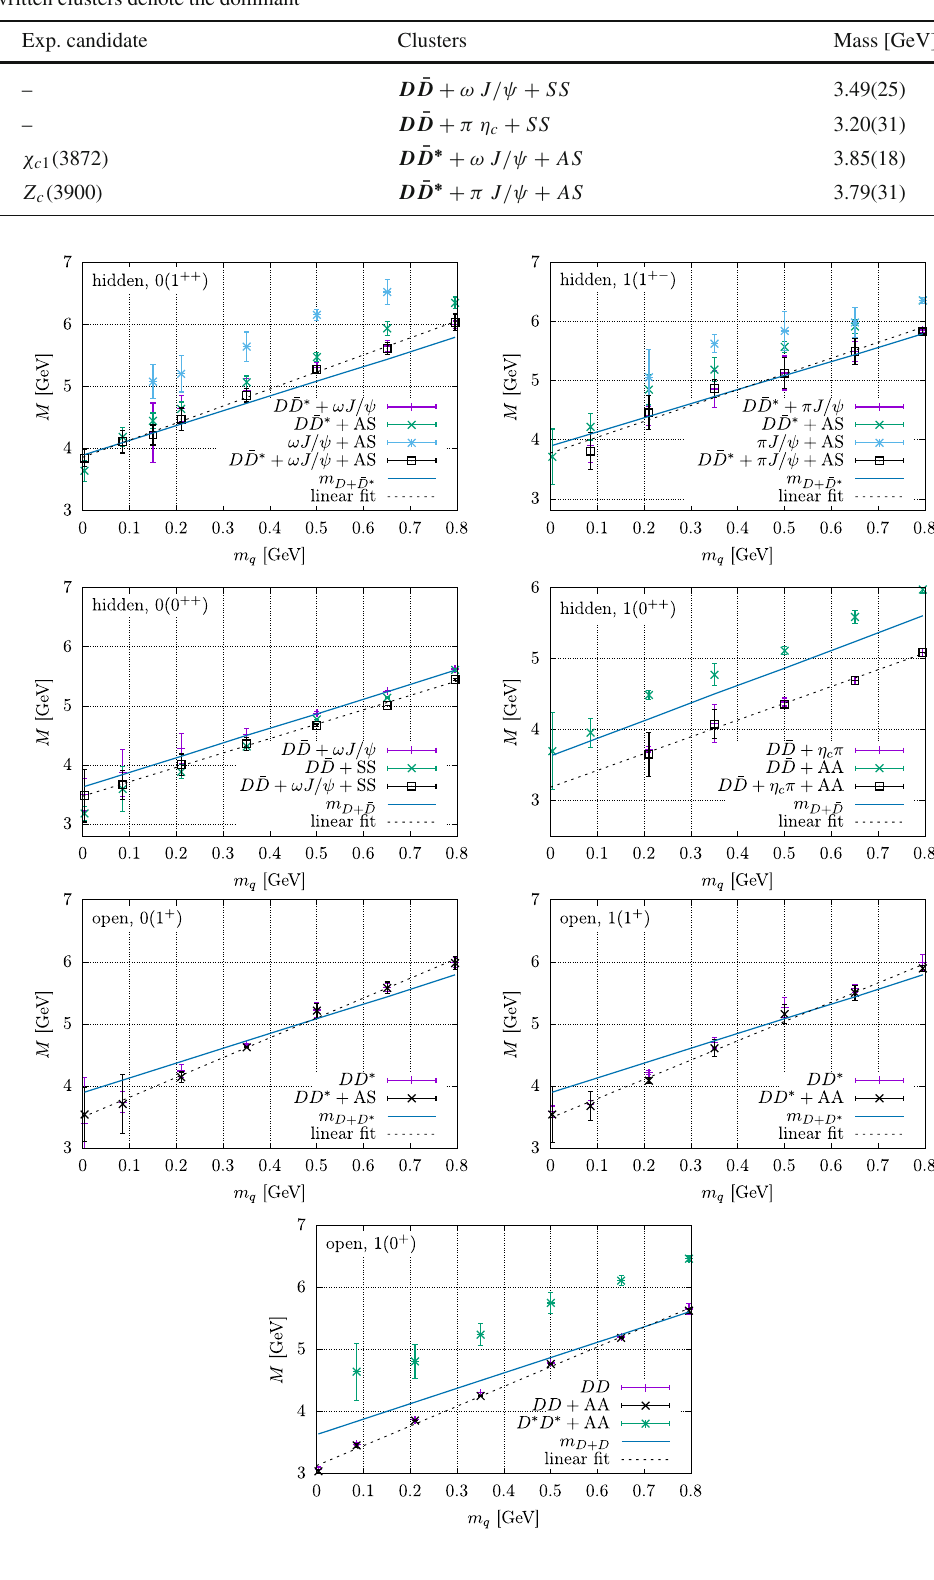
component in the equation. A and S stand for axialvector and scalar (anti-)diquarks